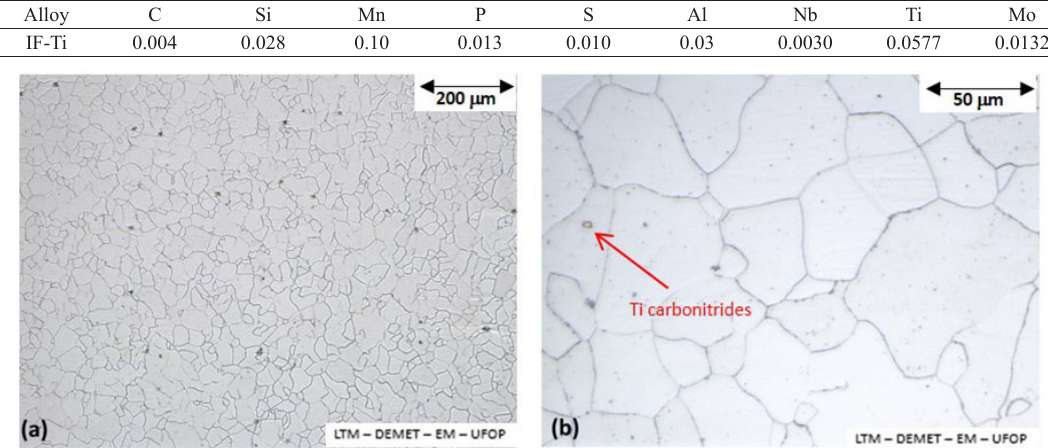
Figure 1. Microstructure of the initial state of IF-Ti steel (a) 100x; (b) 500x. OM – Nital 2%.